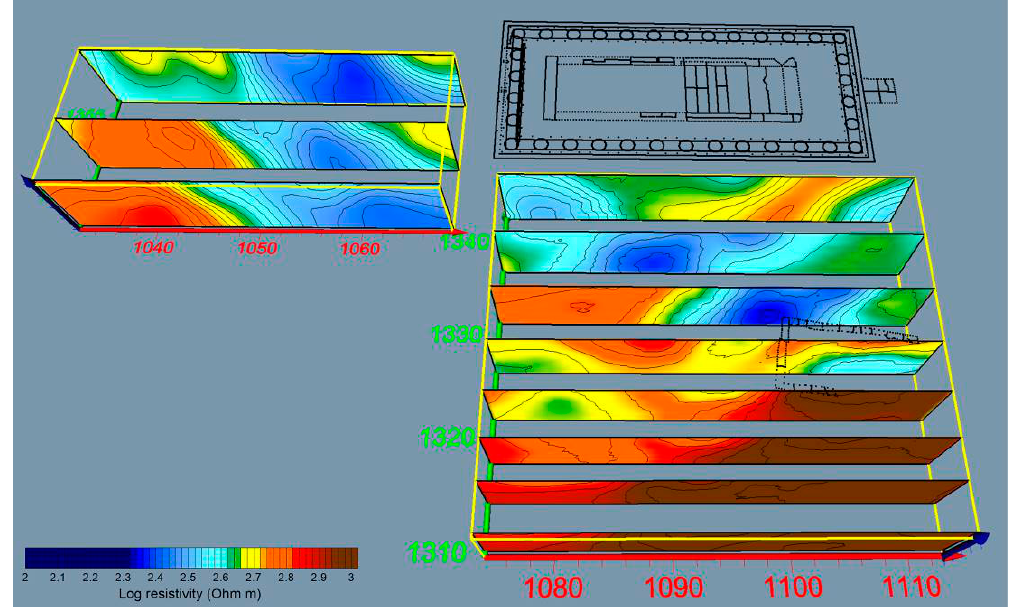
Figure 13. Sequence of vertical tomography sections oriented in the W–E direction.